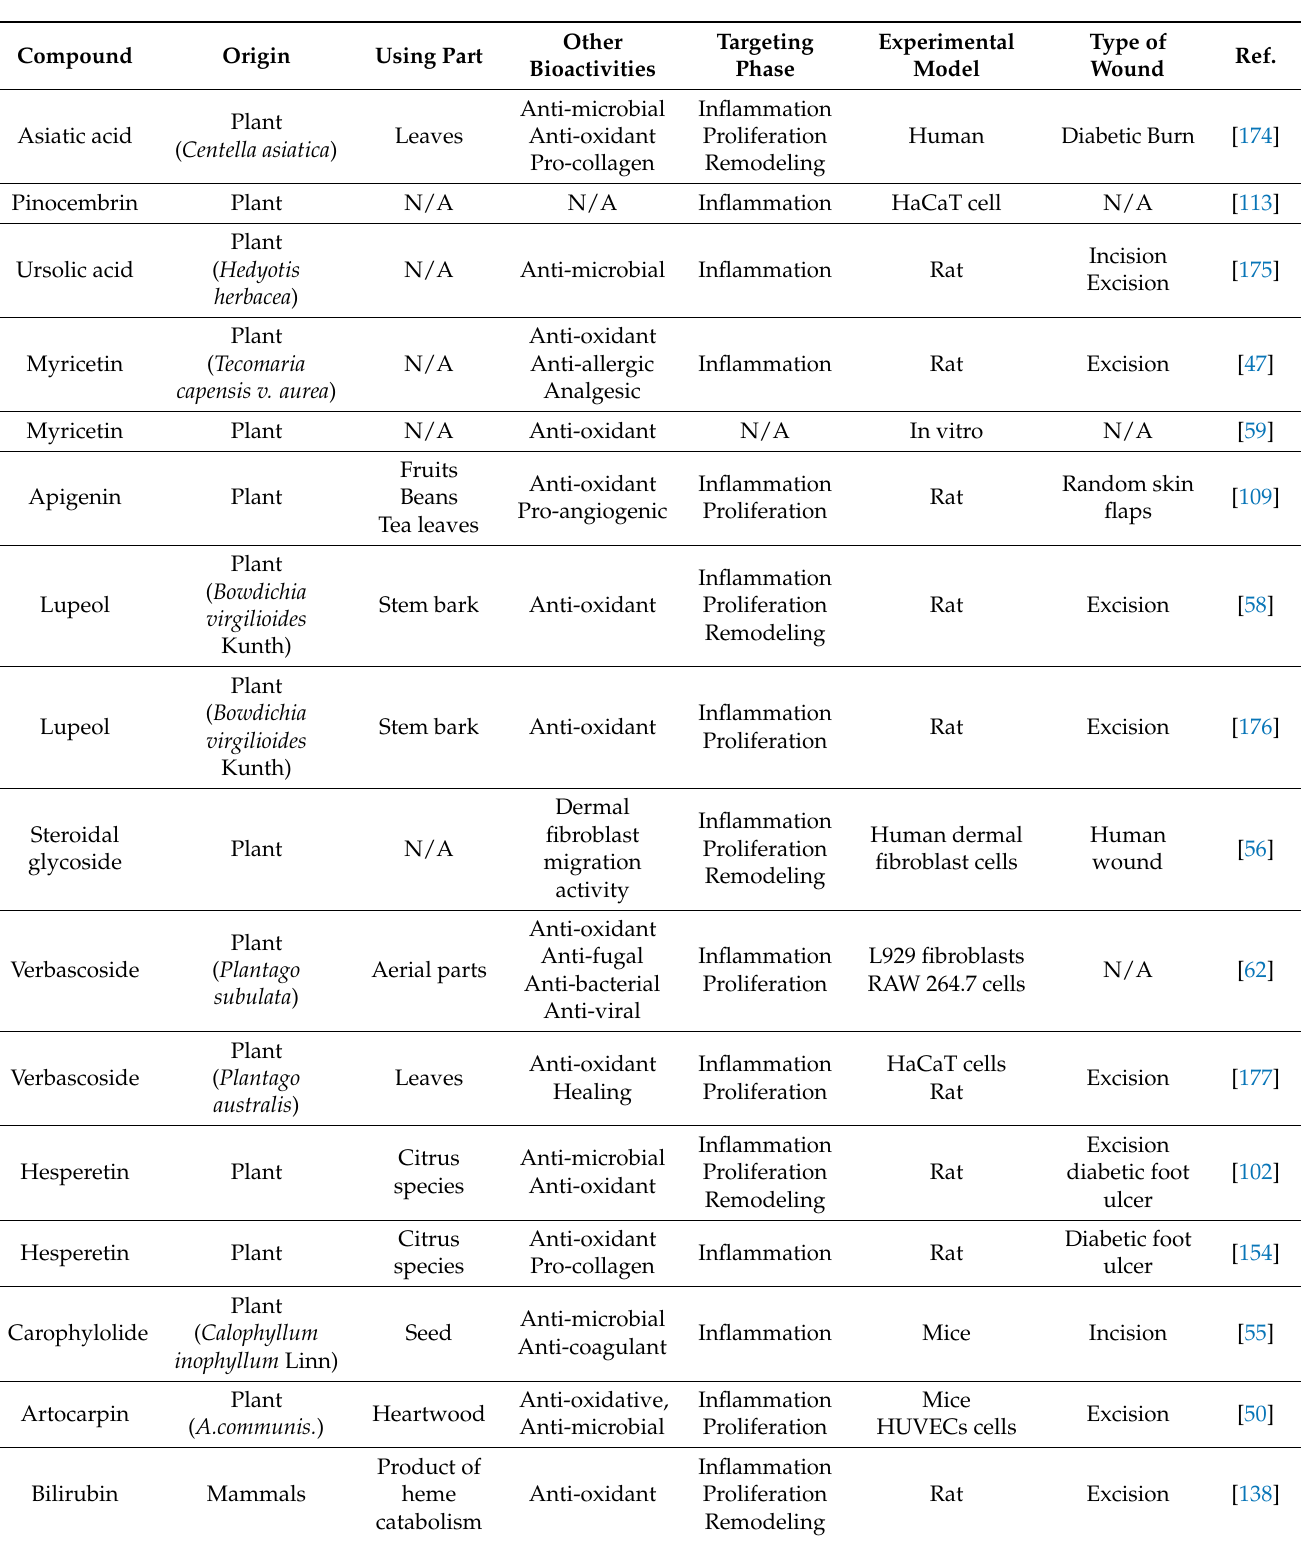
Table 1. Compounds with